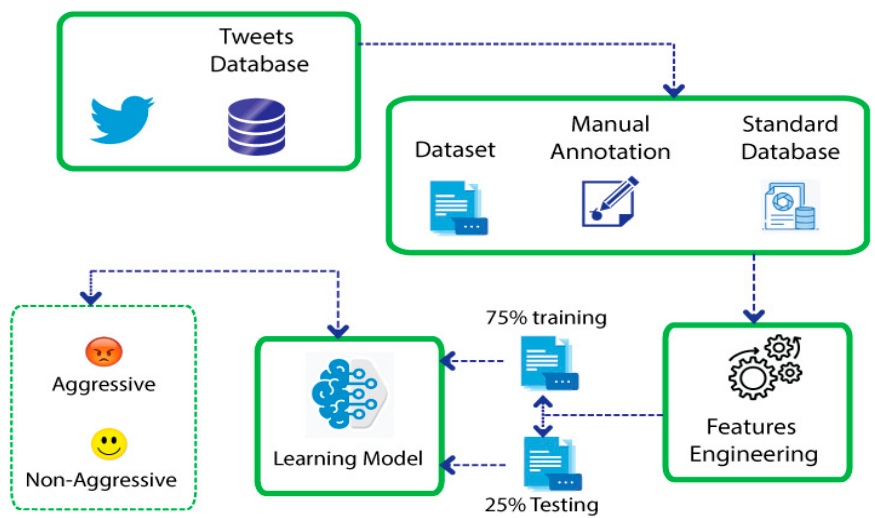
Figure 4. Proposed System Model for Behavior Detection.